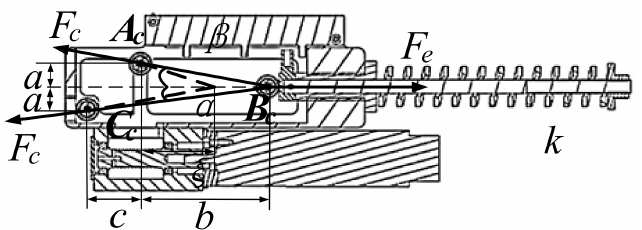
Figure 4. Force analysis of cable SEA mechanism.